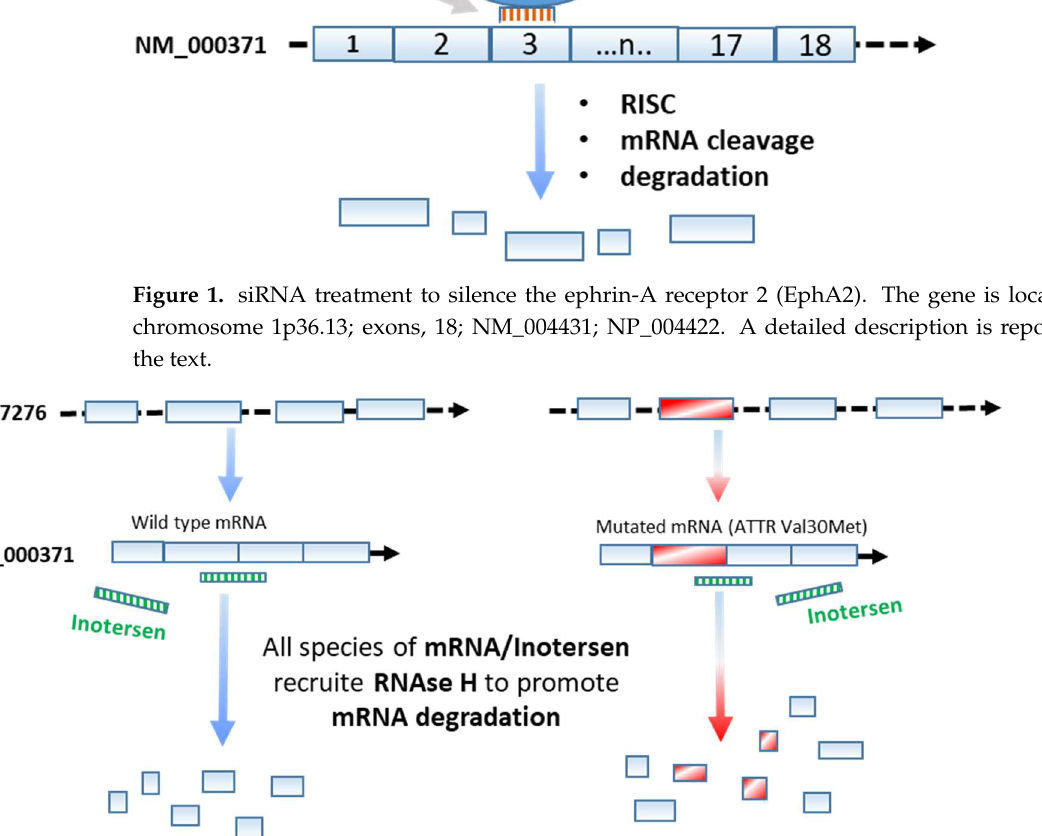
Figure 2. Downregulation of human TTR transthyretin (hTTR) transcripts mediated by ASO Inotersen. The gene (ID 7276) is located on chromosome 18q12.1; exons, 4; NM_000371; NP_000362. A detailed description is reported in the text.